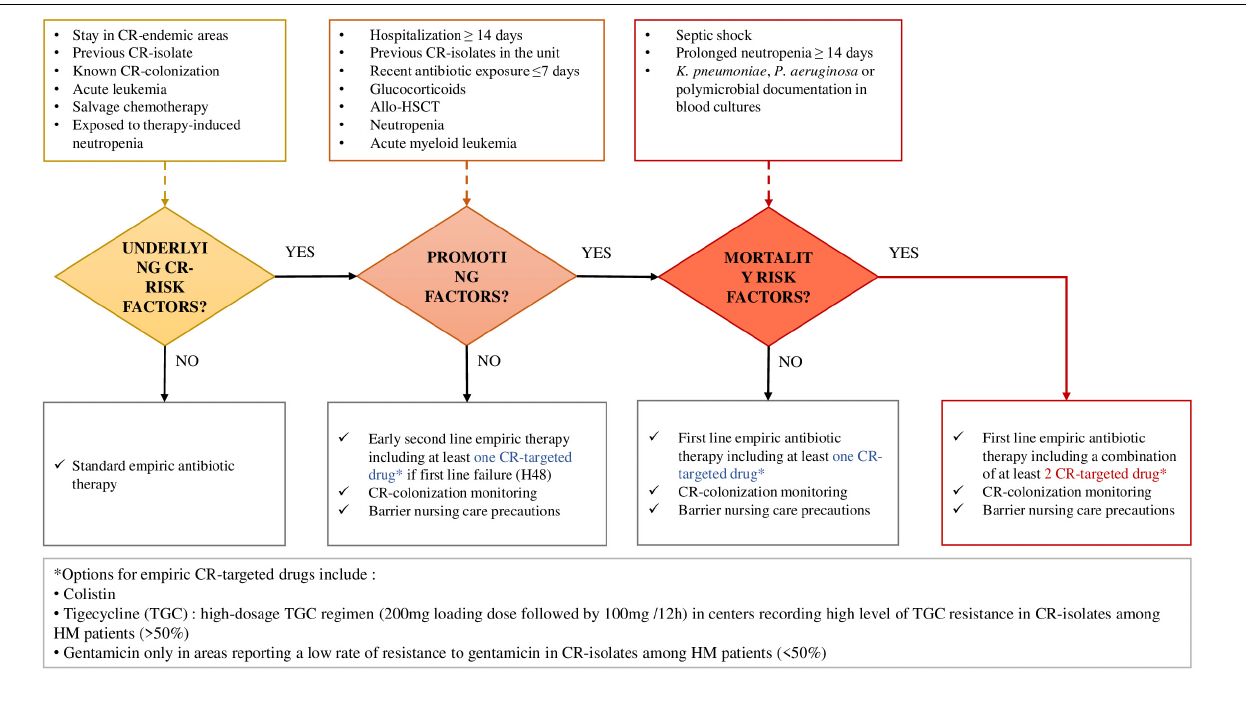
FIGURE 3 | Proposal for CR-bacterial infection risk assessment and empirical management of febrile hematologic patients, based on morbidity and mortality determinants recorded from this literature review.